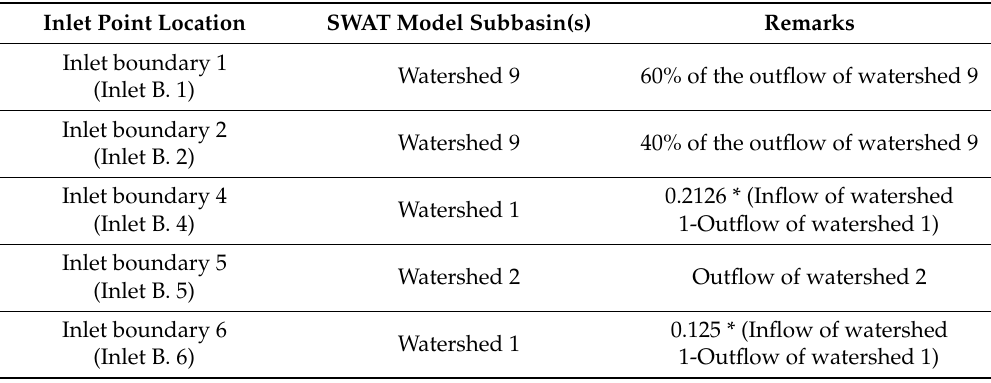
Table 4. Inflows into the hydrodynamic model domain from the SWAT model